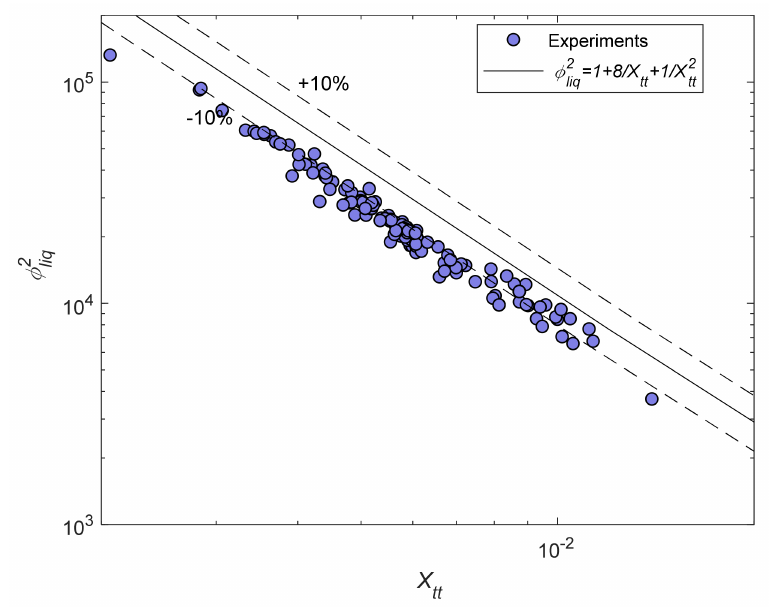
Figure 7. Two phase multiplier factor as a function of the Martinelli parameter considering the two phases as turbulent.